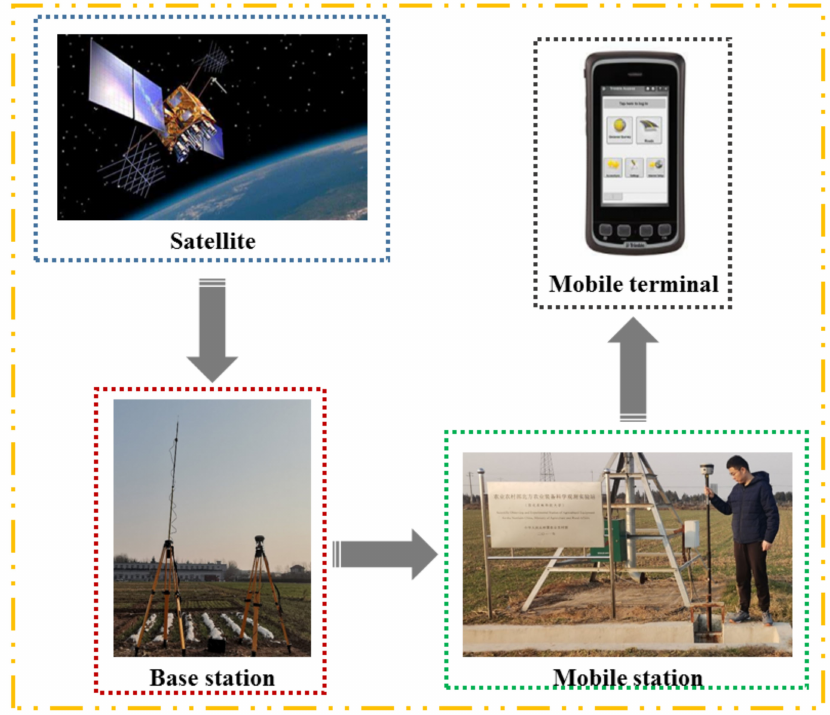
Figure 4. Use Trimble GNSS System to Obtain the Coordinates of Ground Control Points